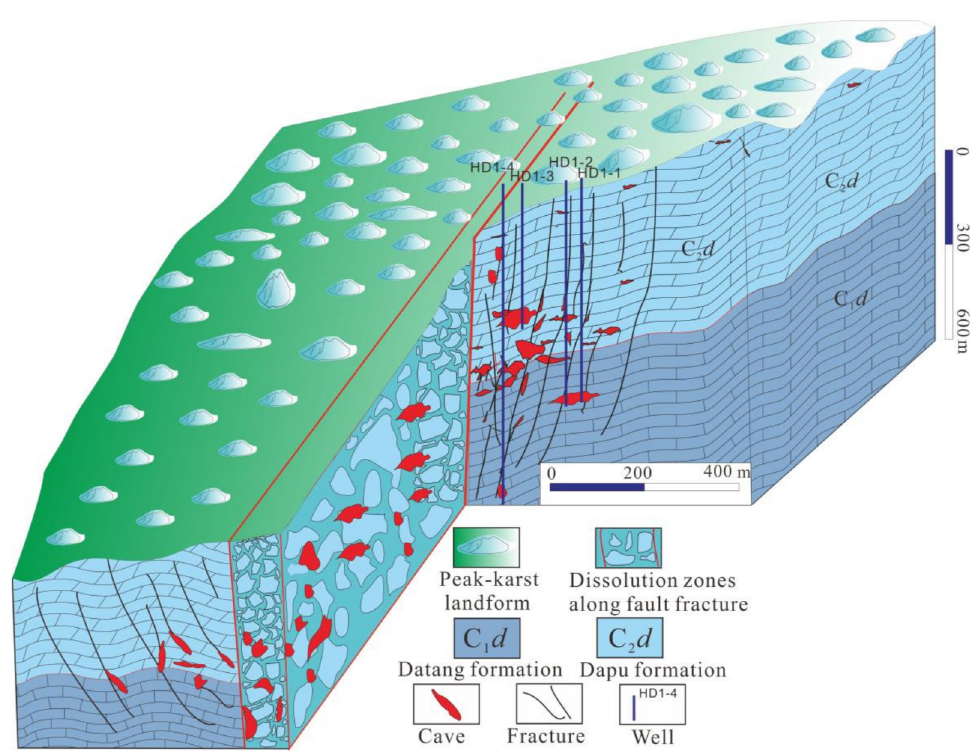
Figure 10. Distribution pattern of deep karst fracture-cavities controlled by a reverse fault in Huan- jiang Sag. The width and height of karst voids was identified by the wide-field electromagnetic method (Figure